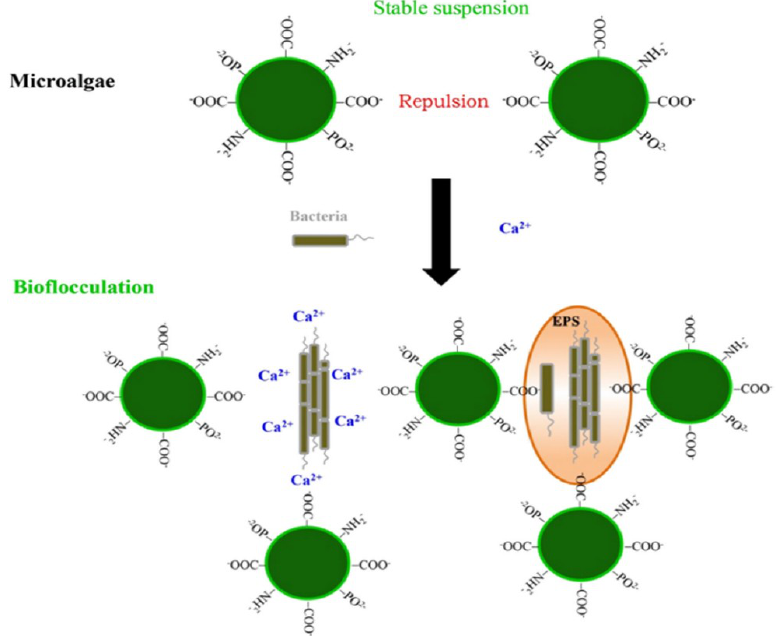
Figure 3. A schematic diagram of bio-flocculation harvesting of algal biomass using bacteria. EPS, extracellular polymeric substances. Reprinted from Reference [27] with permission from Springer Nature.